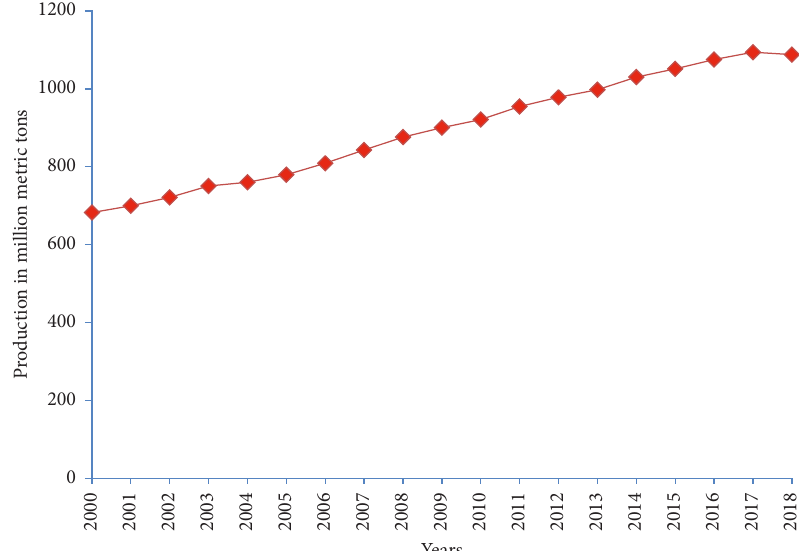
Figure 1: Volume (in million metric tonnes) of vegetables produced globally